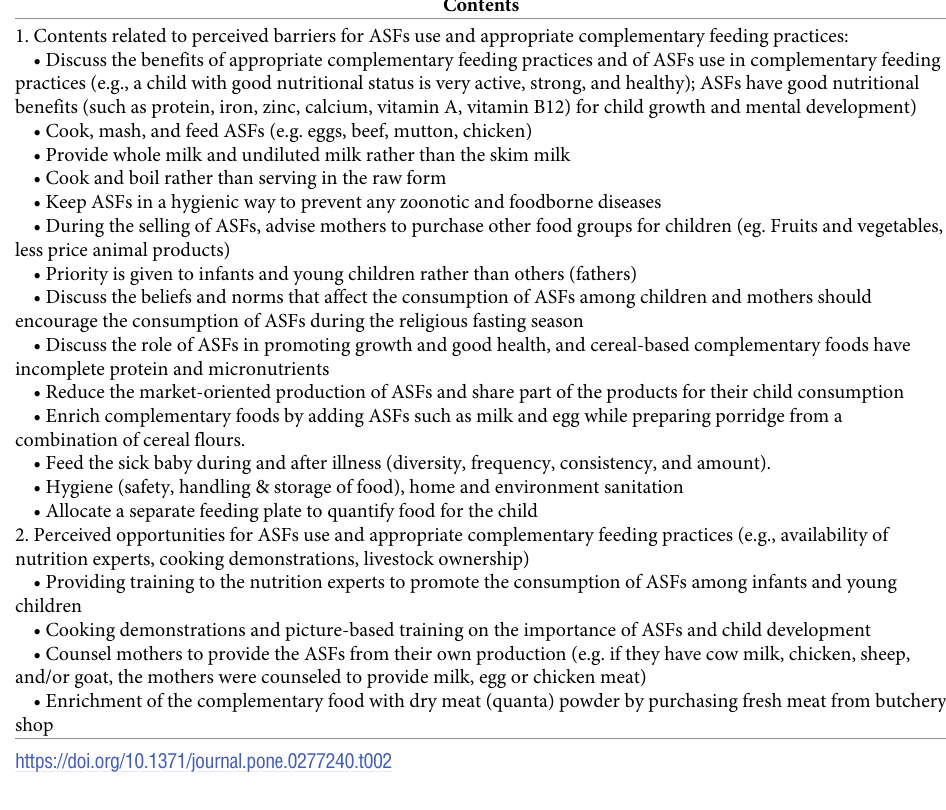
Table 2. Contents of the nutrition education sessions provided to mothers of 6–23 months old